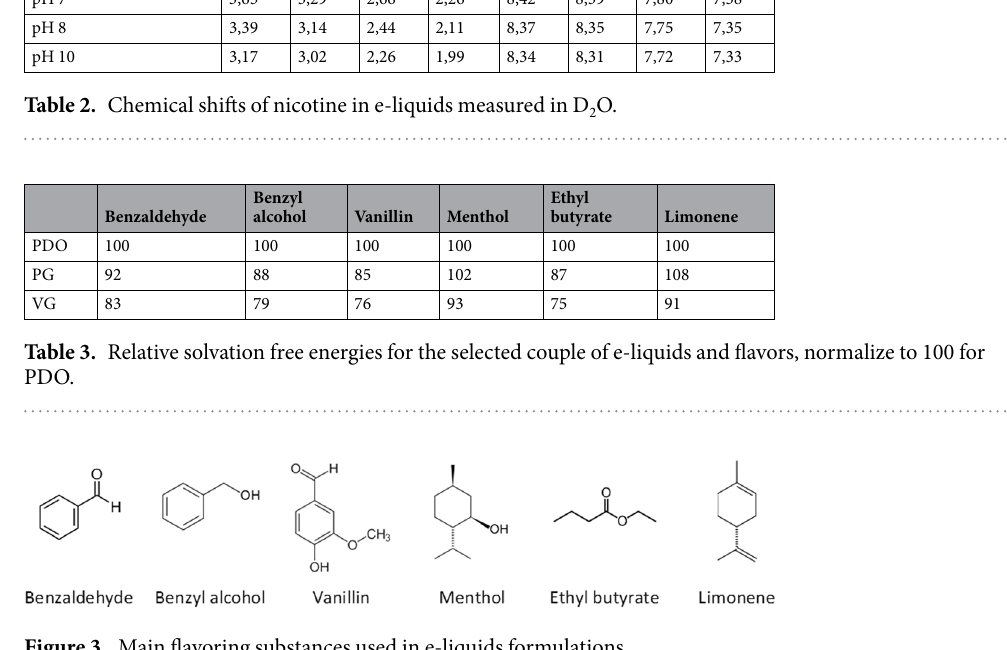
Figure 3. Main flavoring substances used in e-liquids formulations.